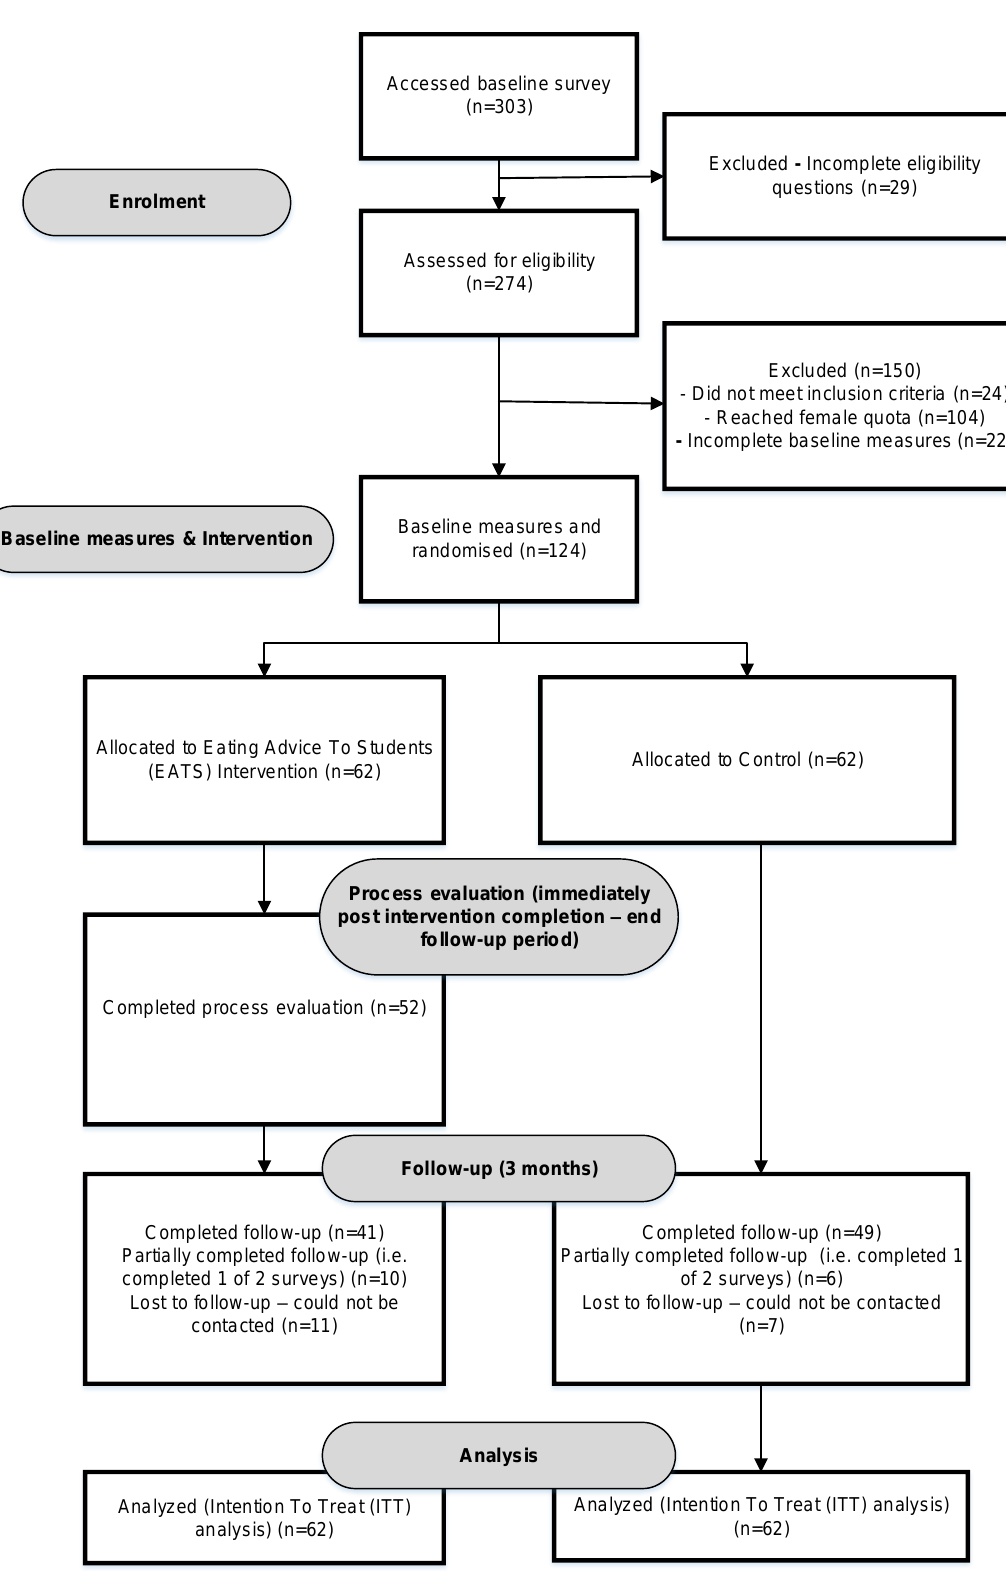
Figure 1. CONSORT flow chart describing participant progress through the Eating Advice to Students (EATS) pilot randomized controlled trial.